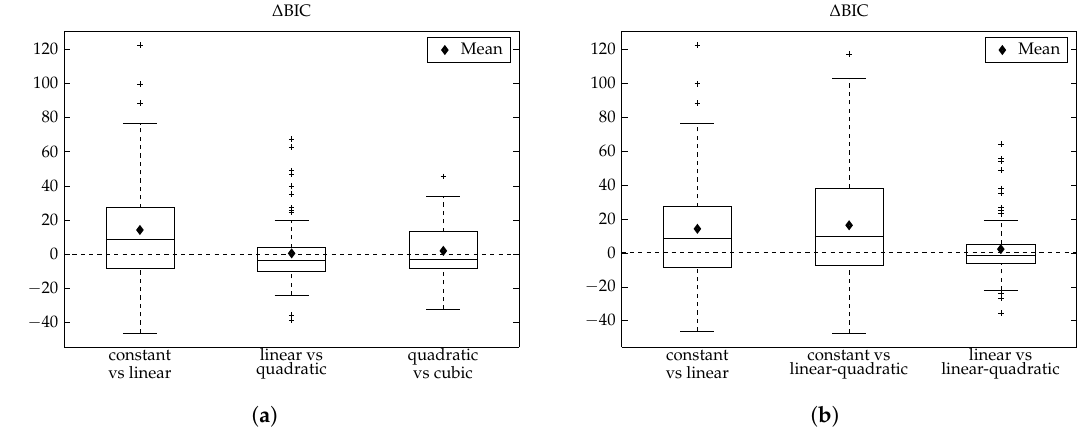
Figure 3. Boxplots of ∆ BIC. ( a ) comparison between the non-hybrid models. ( b ) determination of the orders m and l of the polynomials a i ( t ) and b i ( t ) . BIC, Bayesian information